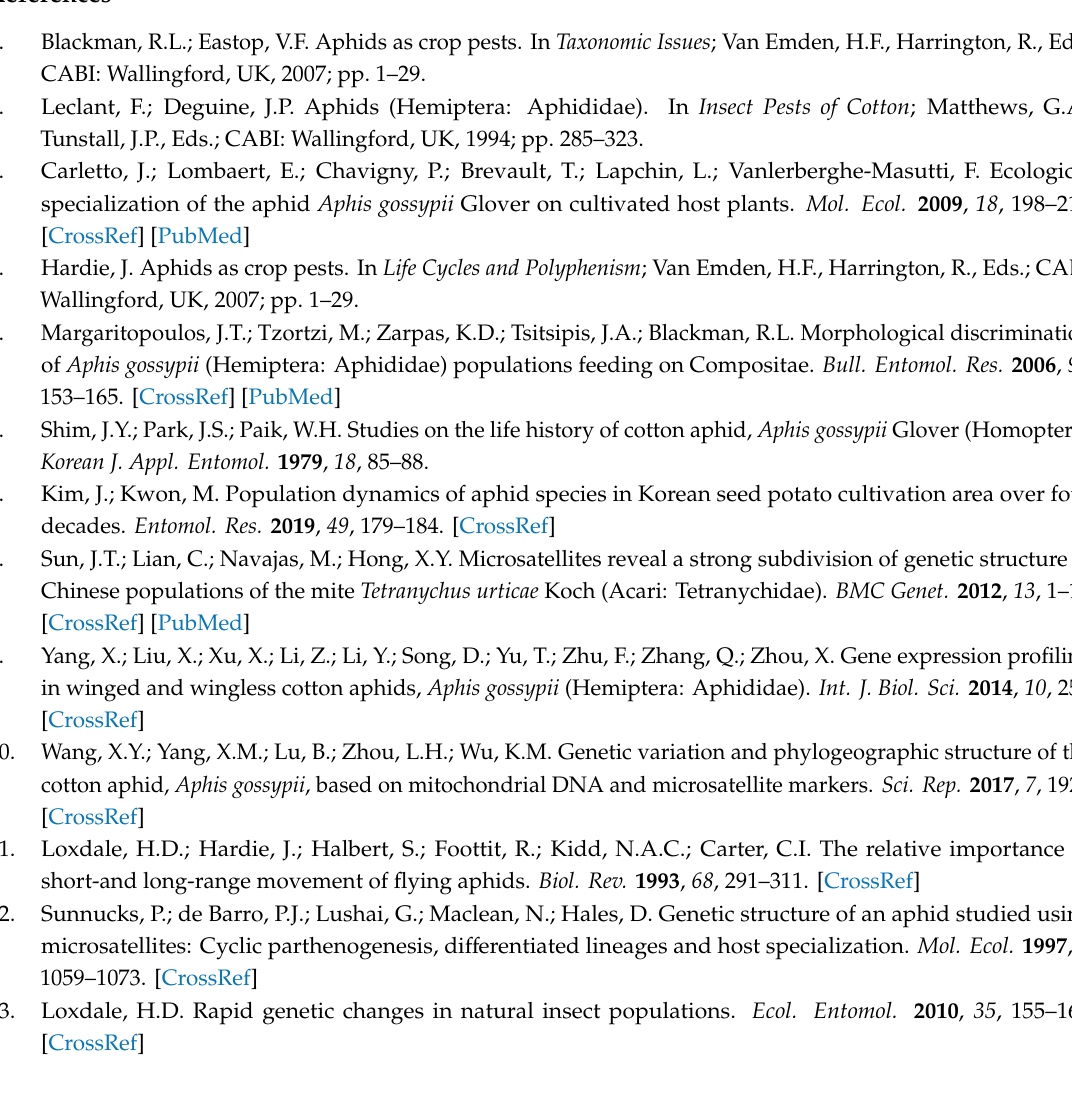
Figure S1: Bayesian inference to identify suitable cluster (K) and cluster proportion using STRUCUTRE for Aphis gossypii in Korea. Delta K are analyzed against number of genetic clusters (K); Figure S2: Scatter plot of DAPC analysis of the nine populations using “adegent” in R package (Table 2 indicates the population ID). Dots: individuals, ellipses: populations; Table S1: Sampling information of A. gossypii collected in Korea (2016, 2017, and 2018); Table S2: Microsatellite loci, number of alleles observed at each locus (NA), observed (HO) and expected (HE) heterozygosity at each locus, and mean PIC (polymorphic information content) per locus in A. gossypii population; Table S3: Pairwise FST[ENA] values (lower-left matrix), and pairwise FST values and significance (upper-right matrix) based on eight microsatellite loci between the populations of A. gossypii in Korea (2016); Table S4: Pairwise FST[ENA] values (lower-left matrix), and pairwise FST values and significance (upper-right matrix) based on eight microsatellite loci between the populations of A. gossypii in Korea (2017); Table S5: Pairwise FST[ENA] values (lower-left matrix), and pairwise FST values and significance (upper-right matrix) based on eight microsatellite loci between the populations of A. gossypii in Korea